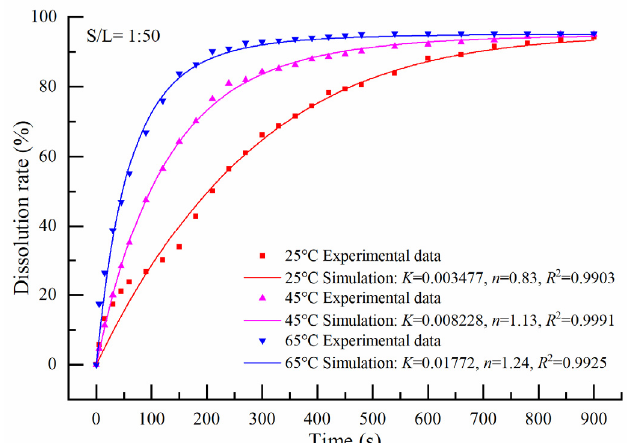
Figure 6. Effects of temperature on chloride ion dissolution rate with S/L ratio of 1:50 and stirring speed of 600